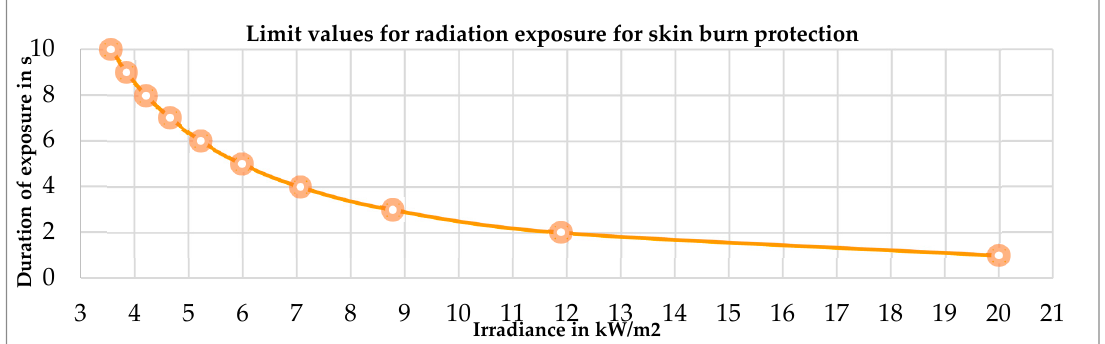
Figure 7. Limit values for radiation exposure for skin burn protection based on